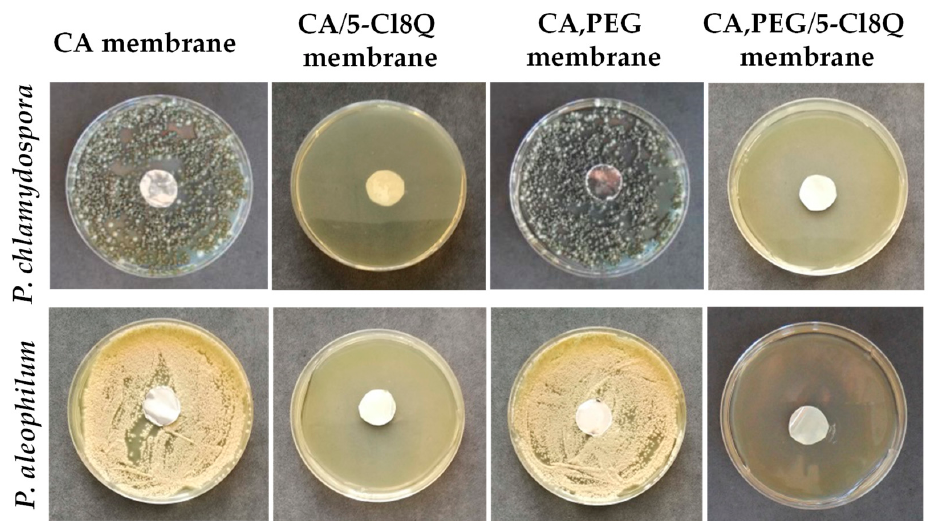
Figure 1. Digital images of the zones of inhibition against P. chlamydospora and P. aleophilum after contact of the membranes with fungi cells. The membrane type is indicated at the top of each column. The cell type is marked in the left of each row [97].